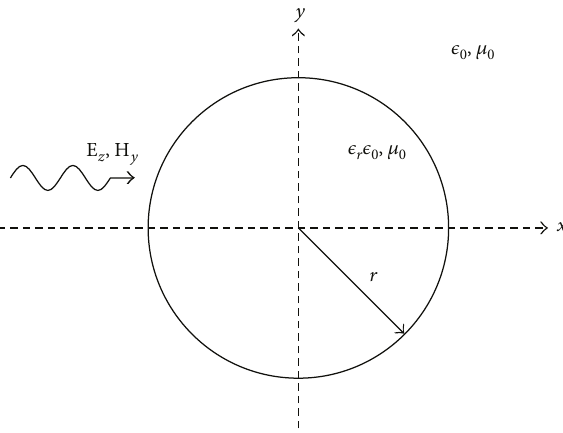
Figure 1: Plane wave incidence on the plasma